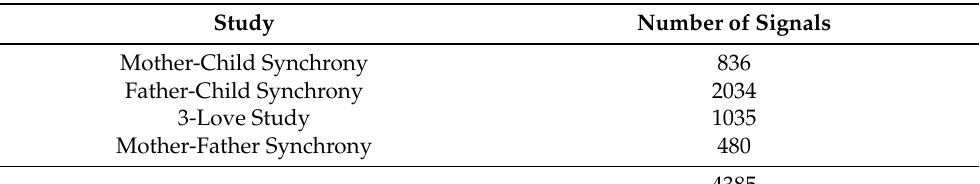
Table 1. Breakdown of the number of signals per study of origin that have been included in the current